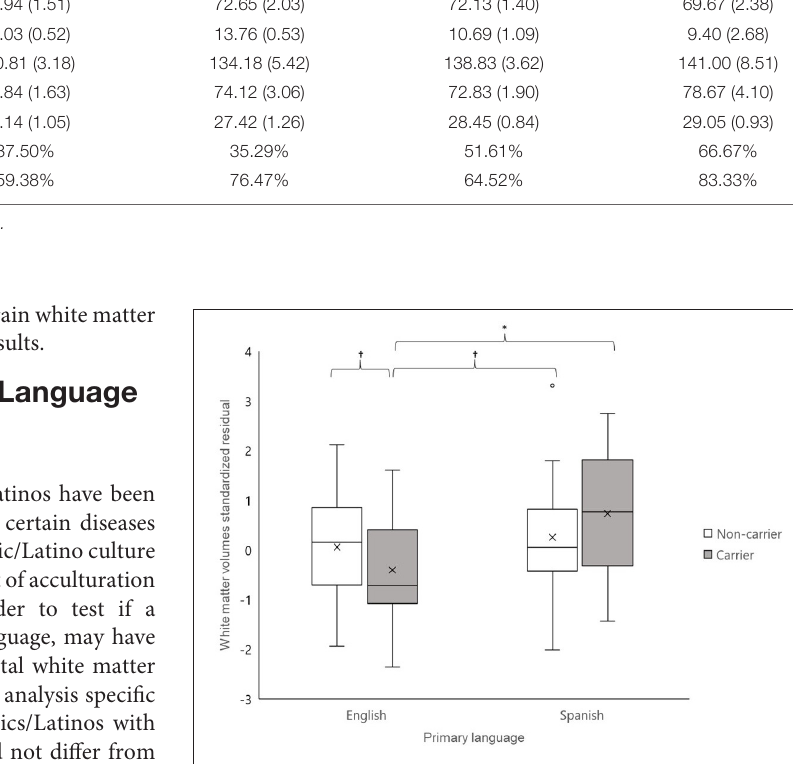
FIGURE 1 | Total brain white matter volumes residualized for intracranial volume for Hispanics/Latinos whose primary language was English (left) and whose primary language was Spanish (right). Apolipoprotein E (APOE) ε 4 carriers whose primary language was English had marginally to significantly smaller white matter volumes than the other three groups ( t s ≥ |1.89|, ps < 0.07), controlling for age and education. No other group differences were detected ( t s ≤ |1.20|, n.s.). † p < 0.10; * p <